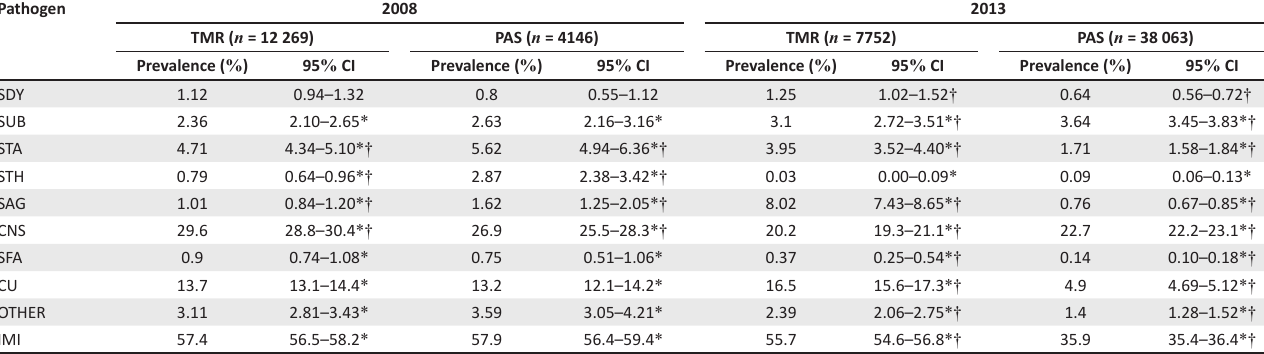
TABLE 1: Prevalence of mastitis pathogens by year (2008 and 2013) and system (total mixed ration- and pasture-based) in South African dairy herds. Pathogen